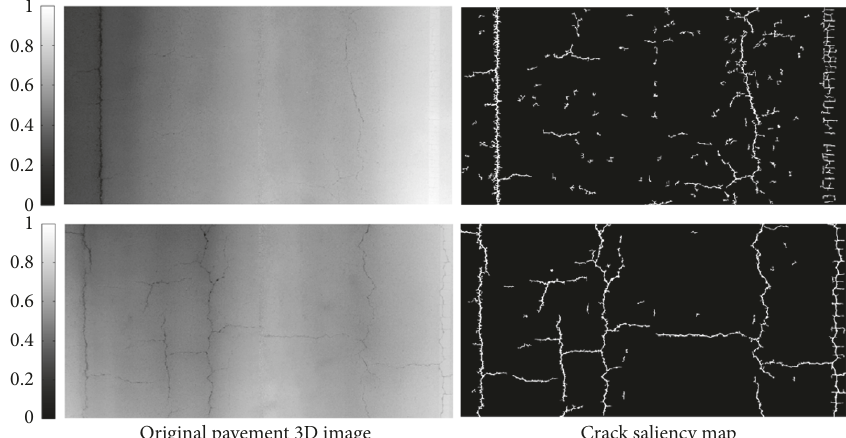
Figure 6: Examples of generated crack saliency maps.